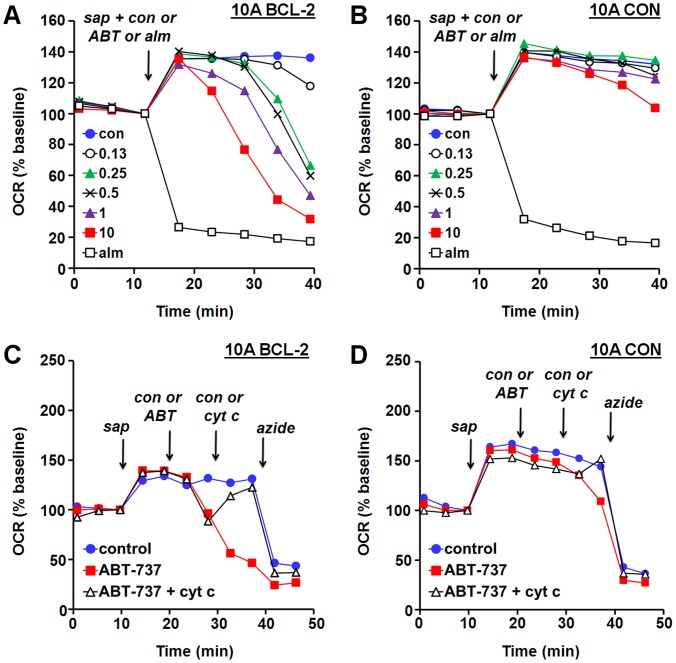
A respiration-based microplate assay detects cell death priming at the level of the mitochondrion.(A) MCF10A BCL-2 cells were exposed at the arrow to saponin (sap, 10 µg/ml) plus succinate (5 mM), rotenone (0.5 mM), ADP (1 mM), K2HPO4 (3.6 mM), and ABT-737 (ABT), vehicle (con), or alamethicin (alm, 80 µg/ml). Numbers in legend correspond to ABT-737 concentration in µM. (B) MCF10A CON cells receiving the treatments described in A. (C) MCF10A BCL-2 cells were exposed to saponin (10 µg/ml) plus succinate (5 mM), rotenone (0.5 mM), ADP (1 mM), and K2HPO4 (3.6 mM), followed by ABT-737 (ABT, 10 µM) or vehicle (con), cyt c (100 µM) or con, and sodium azide (5 mM). (D) MCF10A CON cells receiving the treatments described in C. All results are means from one experiment in triplicate and are representative of at least three independent experiments. OCR is baseline-normalized to the point prior to saponin addition.